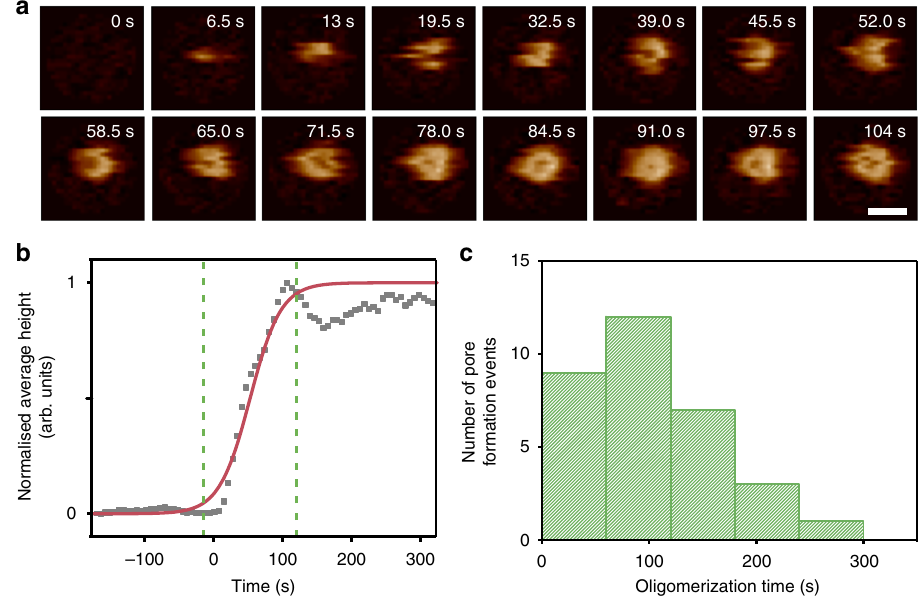
Fig. 4 Real-time imaging of C9 oligomerization. a AFM image sequence of MAC assembly, cropped from data shown in Fig. 3 and Supplementary Movie 1. C9 oligomerization completes within frames shown (104s, 6.5 s/frame; 0 s is here approximately de fi ned by the frame preceding detection of the growing MAC). Scale bar: 30 nm, height scale (see colour scale bar in Fig. 1): 16 nm. b The normalised average frame height versus time for a single pore forming event (corresponding to event shown in a ), plotted here as a measure for completion of MAC assembly. The red line represents a sigmoidal fi t to the data, as a generic and mathematically convenient description of a smooth transition between pore absence and pore completion. The C9 oligomerization time is determined from the width of the transition, highlighted by green dashed lines (see Supplementary Fig. 12 for details). c Distribution of oligomerization times, extracted from n = 33 isolated pore forming events in 6 independent